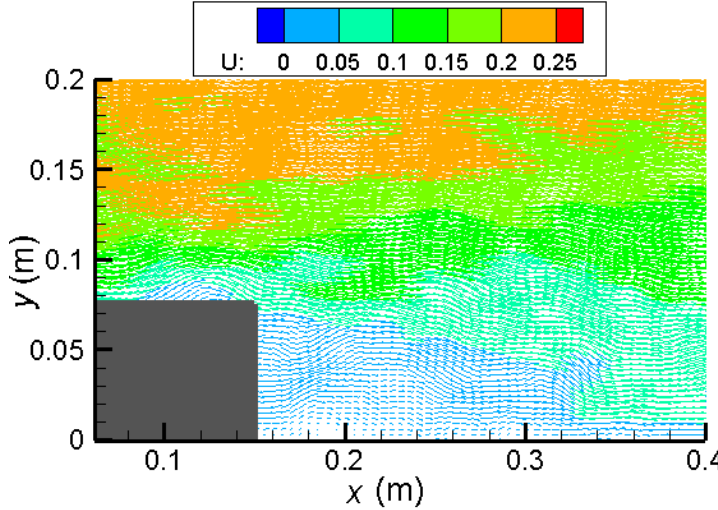
Figure 23. Back vortex field of the pore structure when the porosity is 0.349. U: Longitudinal velocity (m/s).